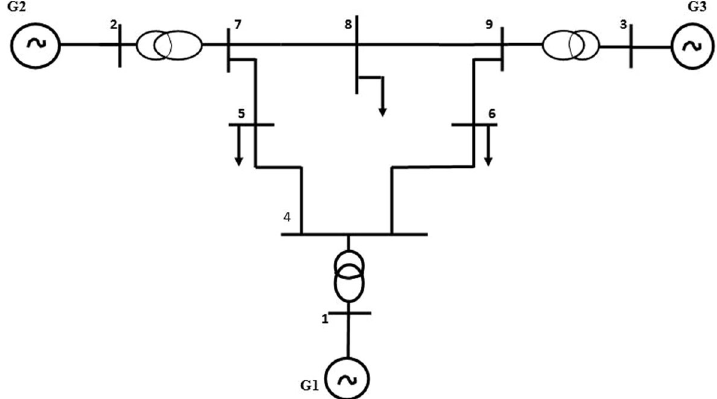
Fig. 5 Three generator nine bus test